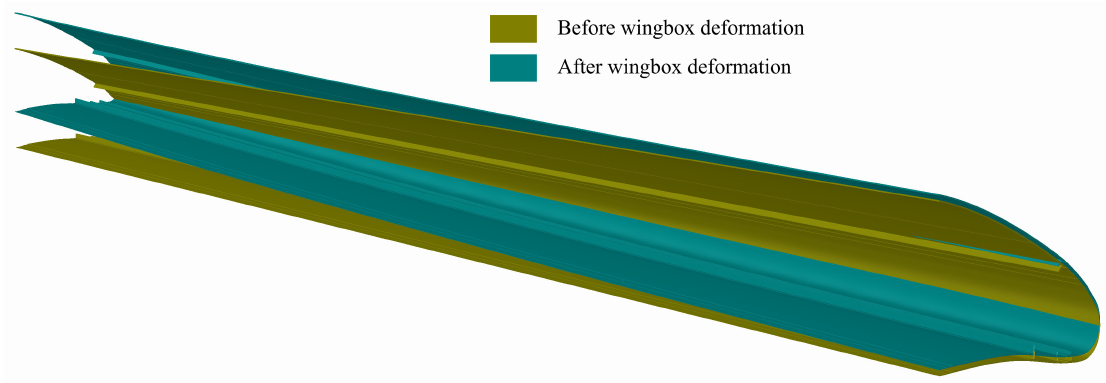
Figure 23. Leading edge deformation shape before and after the wing-box deformation.